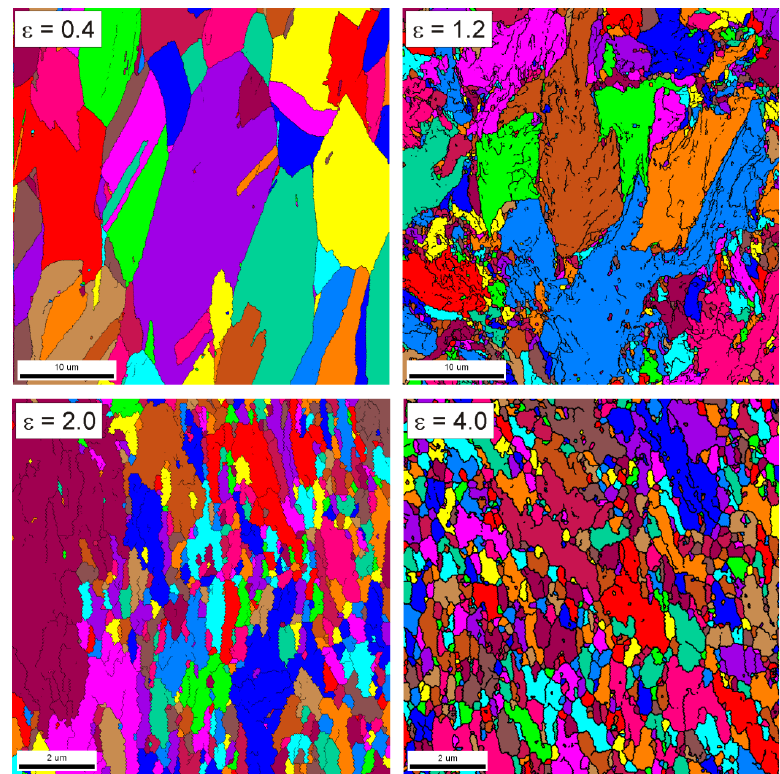
Figure 9. Deformation microstructures (unique grain color mapping) developed in a 304-type stainless steel during multiple forging to indicated total strains at 773 K [70]. The change in the grain size distributions during multiple forging at 773 K or 973 K is represented in Figure 11 [70]. A huge peak corresponding to rather coarse original grains is observed at a relatively small strain. This peak decreases and spreads out to- wards small grain sizes during further SPD. It should be noted that a kind of bimodal grain size distribution with two peaks against small and large grain sizes evolves at inter- mediate strains. Thus, the development of UFG microstructure is accompanied by an in- crease in the peak at small grain sizes and gradual disappearance of the peak at large grain sizes. Finally, a peak corresponding to the new ultrafine grains stands up in the grain size distribution evolved at sufficiently large total strains. Such changes in the grain size dis- tribution were frequently observed during discontinuous DRX under hot working condi- tions [10]. It can be concluded that the changes in the grain size distributions during DRX are almost the same irrespective of different DRX mechanisms.